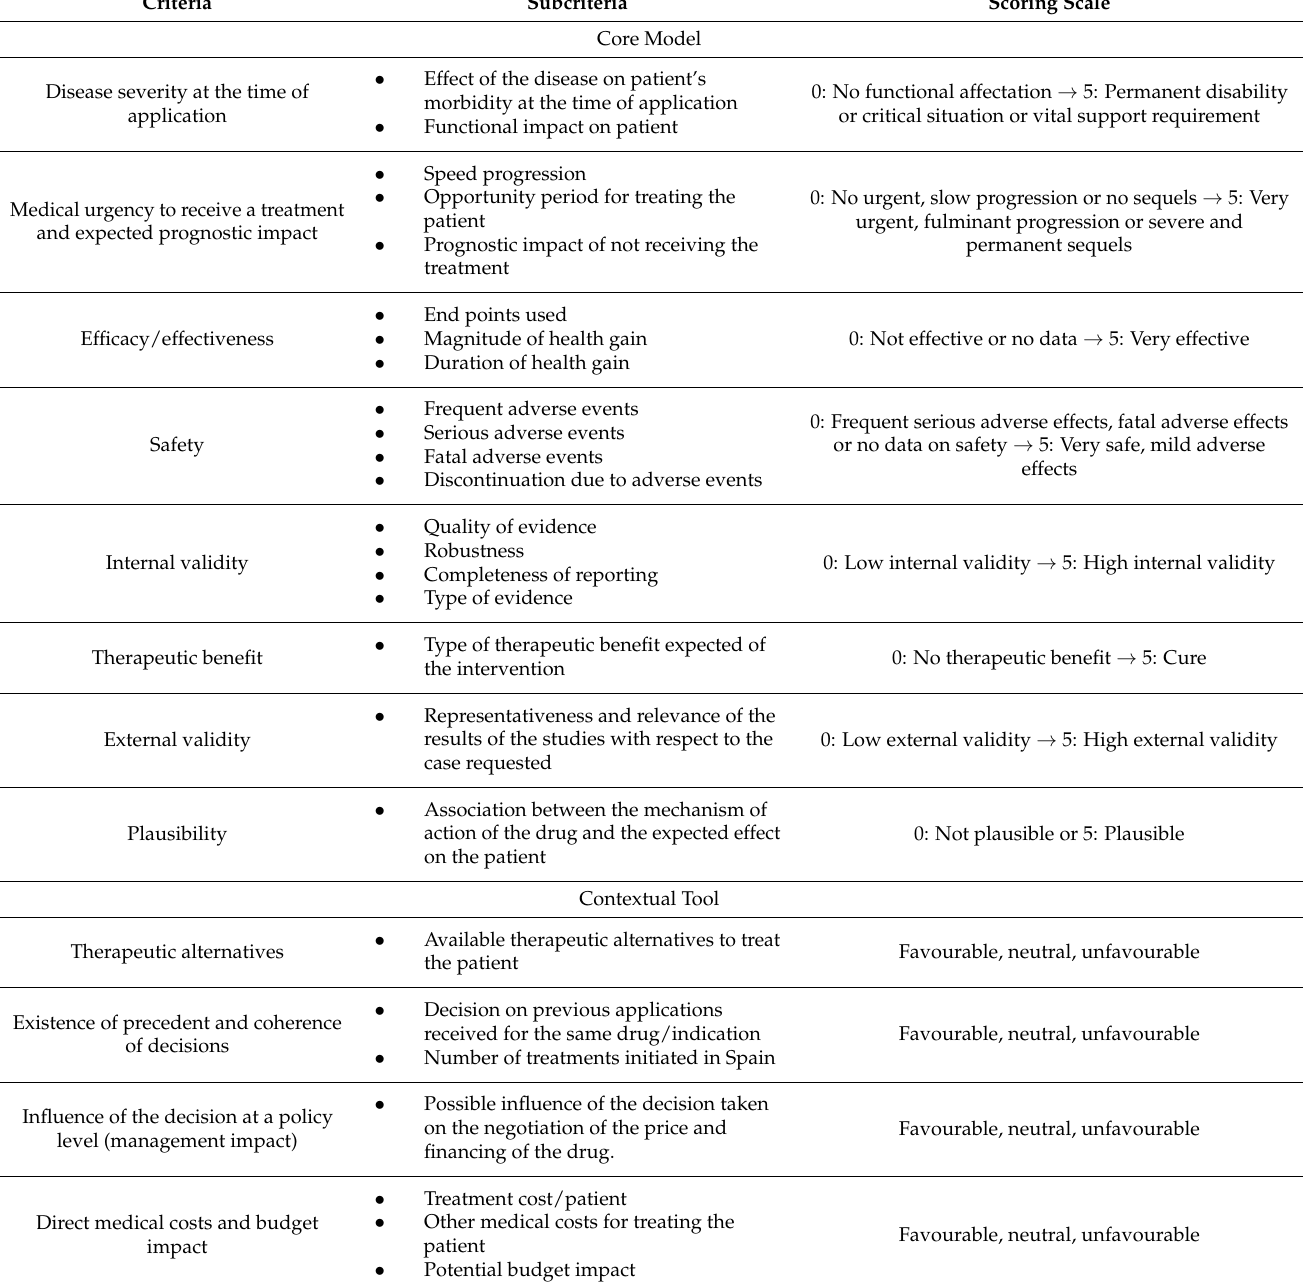
Table 2. Final MCDA core model and MCDA contextual tool for early access